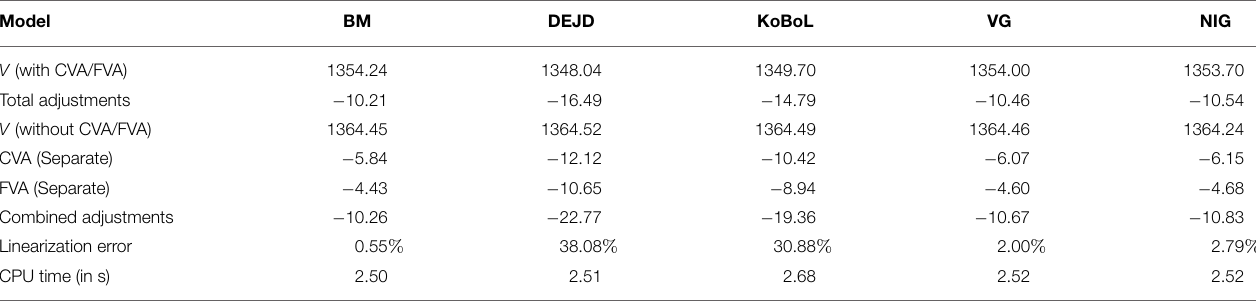
FVA (Separate) Linearization error